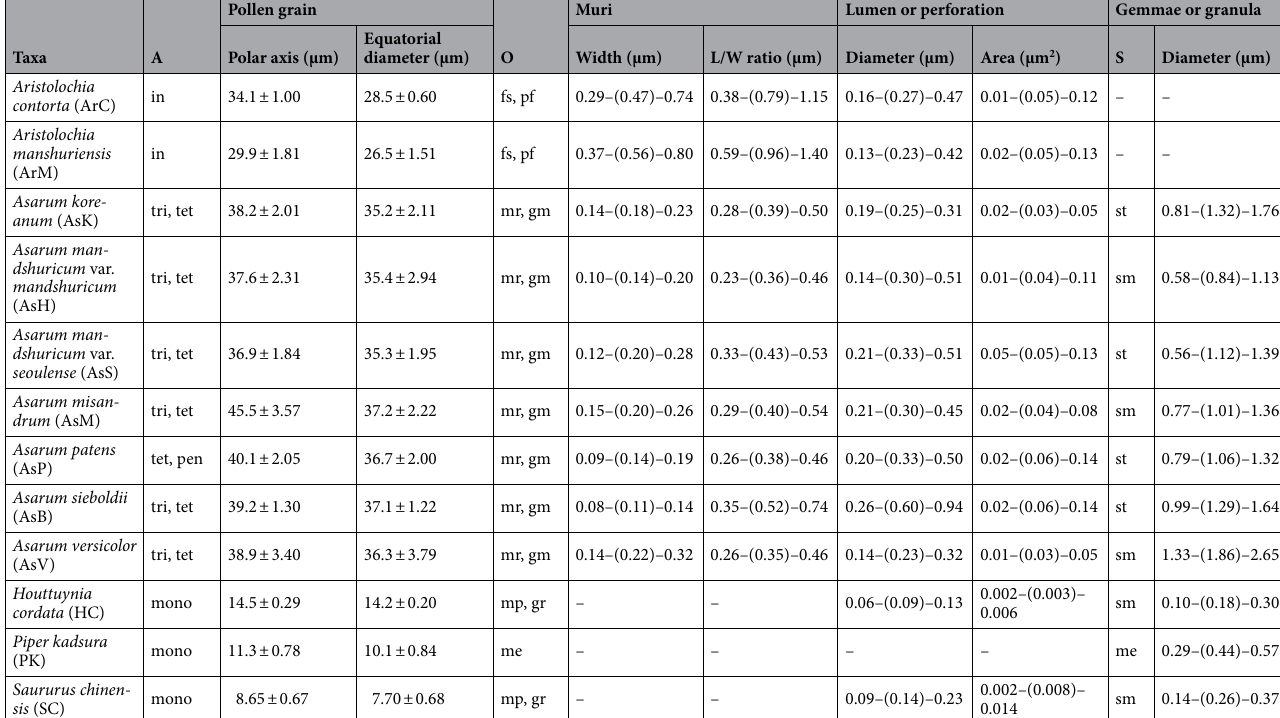
Table 1. Overview of pollen morphological characters in the Korean Piperales taxa. Aperture (A): in inaperturate, mono monosulcate, pen pentaporate, tet tetraporate, tri triporate. Ornamentation (O): fs fossulate, gm gemmate, gr granulate, pf perforate, me microechinate, mp microperforate, mr microreticulate. Gemmae or granula surface (S): me microechinate, sm smooth, st striate. Polar axis and equatorial diameter show mean ± S.D. and muri, lumen or perforation show minimum–(mean)–maximum.